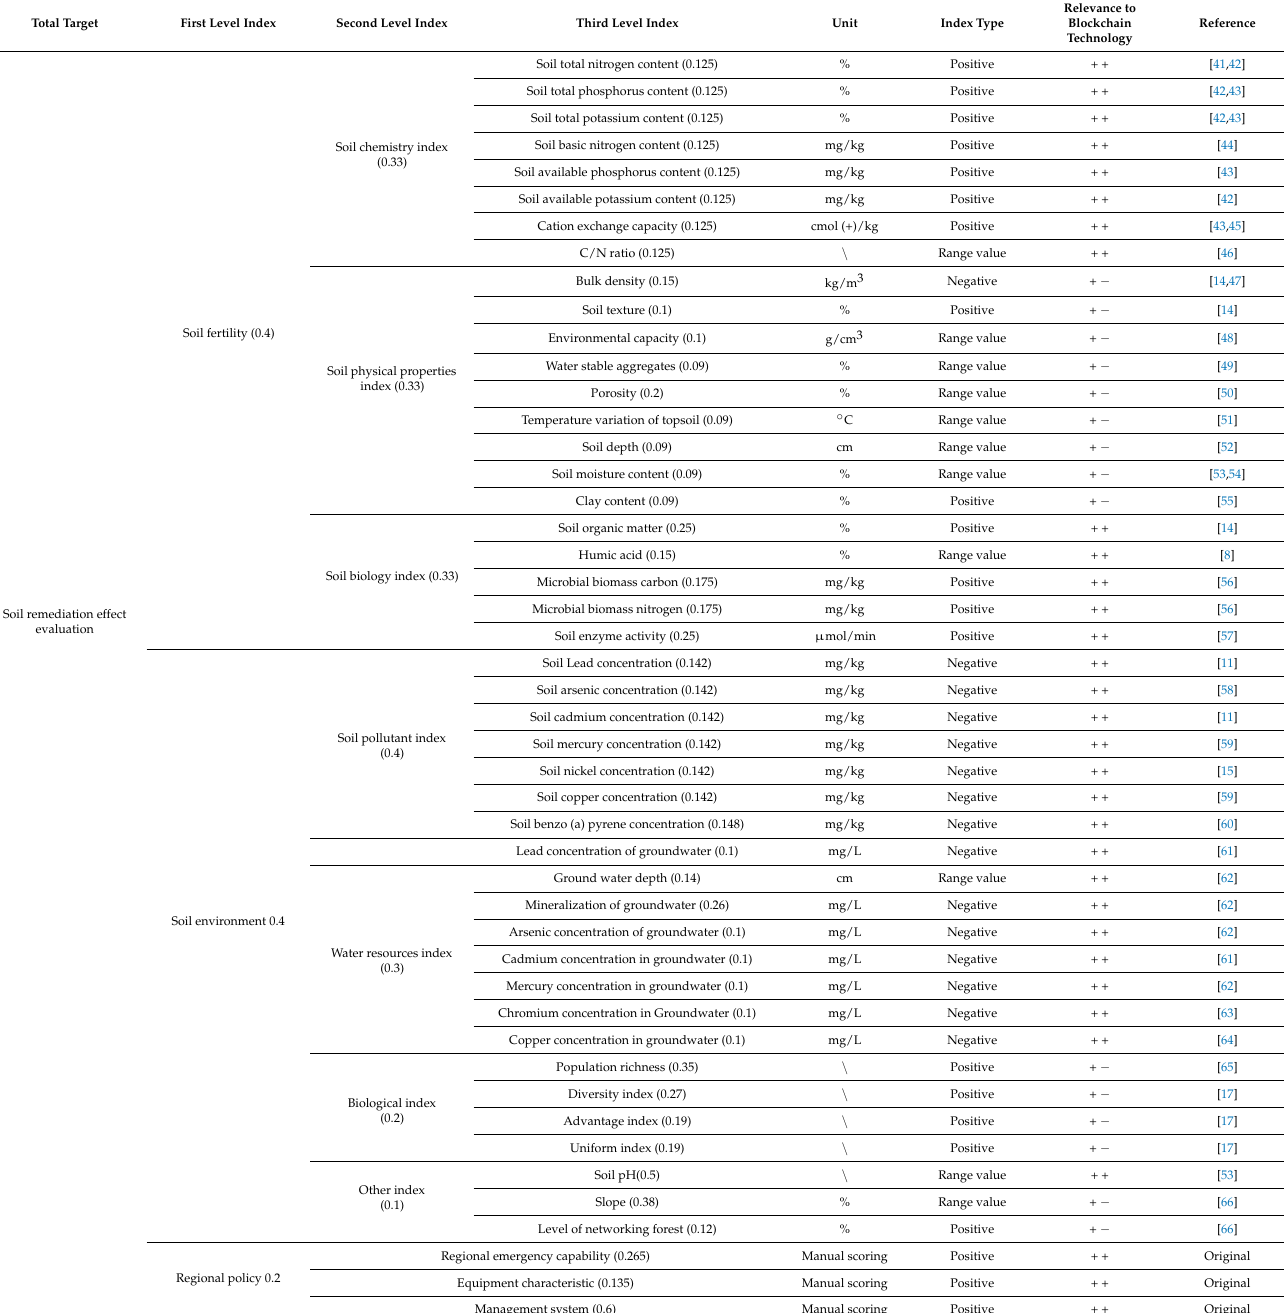
Table 4. Recommended index system for soil remediation effect